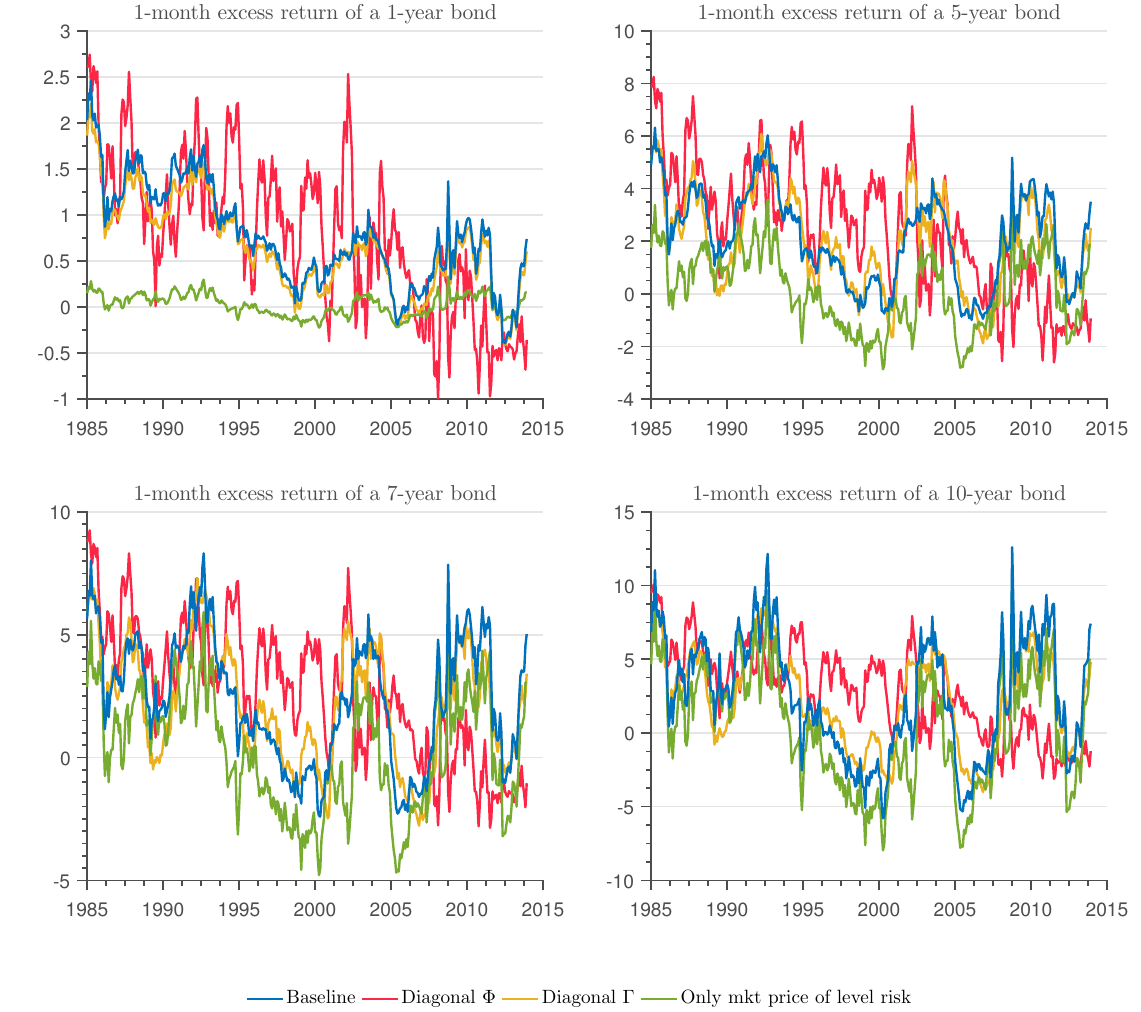
Figure 4. One-month expected excess returns: different models and